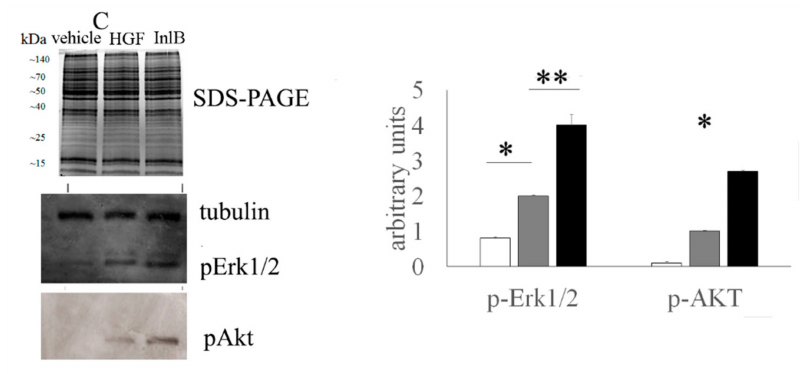
Figure 1. InlB321 / 15 activates Erk1 / 2 and Akt-controlled signaling pathways and provides a mitogenic effect in vitro. ( A ) MTT testing of HepG2 cell survival and proliferation. Cells were grown for 72 h with increasing InlB321 / 15 concentrations (100, 250, 500, or 1000 ng · mL − 1 ) or rhHGF (100 ng · mL − 1 , as recommended by a manufacturer); ( B ) distribution of phospho-Erk1 / 2 in cells. Cells were treated with InlB321 / 15 or rhHGF for 15 min, then labelled with Hoechst to label nuclei, phospho-Erk1 / 2-specific antibodies and Alexa Fluor 488-labelled secondary antibodies, and observed with fluorescent microscopy; scale bar 50 µ m; ( C ) Coomassie R-250 stained SDS-PAGE and Western blotting with anti-phospho-Erk1 / 2, anti-phospho-Akt and anti-tubulin specific antibodies, cell lysates were obtained from cells treated with InlB321 / 15 (250 ng · mL − 1 ) or rhHGF (100 ng · mL − 1 ) for 15 min; the densitogram shows corresponding values (white, gray and black graphs for vehicle, HGF and InlB321 / 15, respectively); ( D ) phospho-Erk1 / 2 and phospho-Akt were measured with InstantOne ELISA TM (Invitrogen) in cell lysates obtained as in ( C ), data designations as in ( C ). Data represents mean values ± SD; * p < 0.05, ** p <